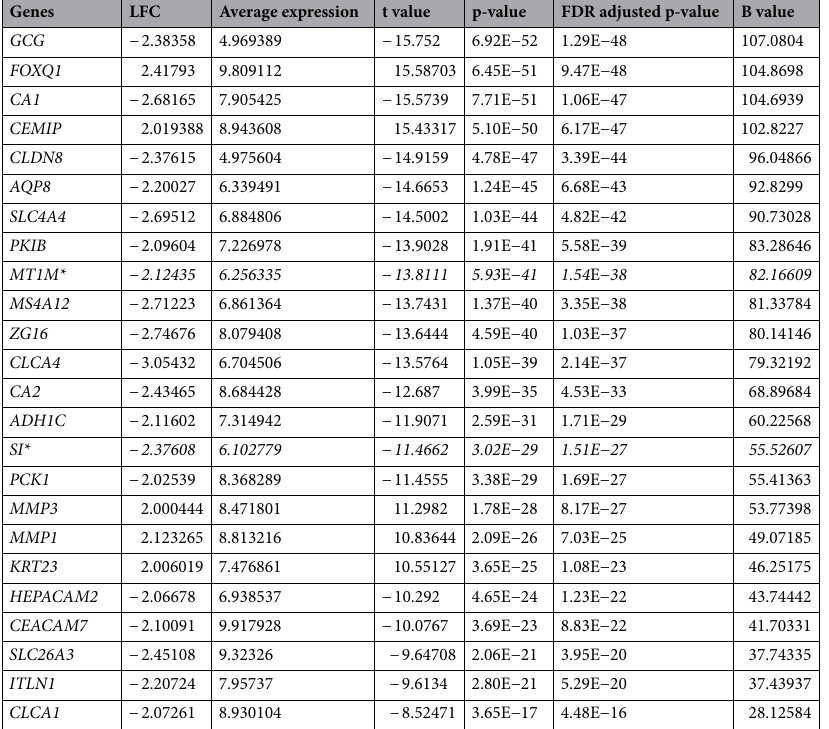
Table 2. DEGs (Differentially Expressed Genes) in the CRC dataset. The genes that exhibited adjusted p-value of ≤ 0.05 and Log2 Fold Change (LFC) ≥ 2 (two) were considered as DEG in the CRC dataset. DEGs that are also present in the list of salient genes are denoted by